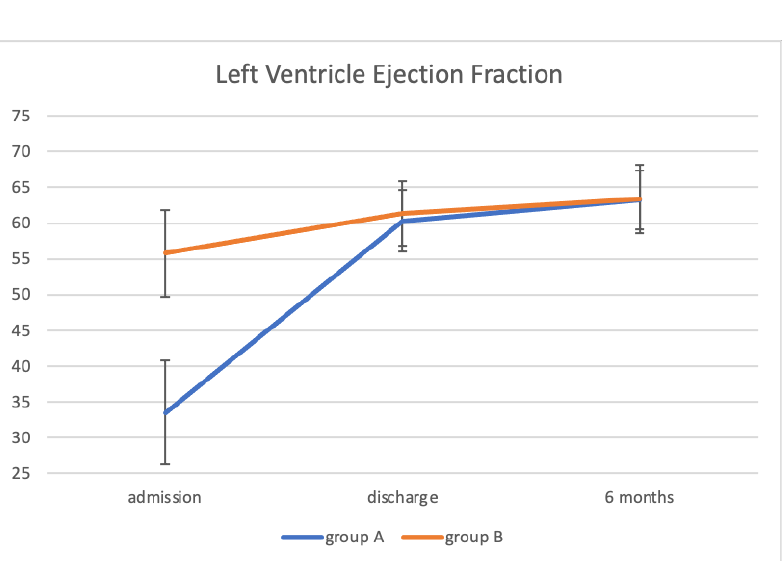
Figure 1. Left ventricle ejection fraction trends from the admission to the 6-month follow-up. Ejection fraction improved at the discharge and remains within the normal range at the medium-term follow-up. Table 3. Results of echocardiographic parameters in the early (discharge) and late (6 months fol- low-up) evaluation, divided into group A and group B. Variables are expressed in mean (± stand- ard deviation) and median (and interquartile range) for Z-score values. Legend. BSA (body surface area), EDD (end-diastolic diameter), EDV (end-diastolic volume), EF (ejection fraction), IVSd (in- terventricular septum diastolic), LAS (left atrium strain), LV GLS (left ventricle global longitudinal strain), ns (not significant), PWd (posterior wall diastolic), RVFWLS (right ventricle free wall lon- gitudinal strain), TAPSE (tricuspid annular plane systolic excursion). Echocardiographic Variables